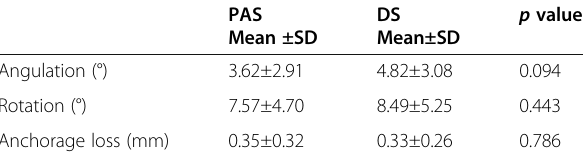
Table 4 A comparison of the 3-month angulation, rotation, and anchorage loss changes of the PAS and